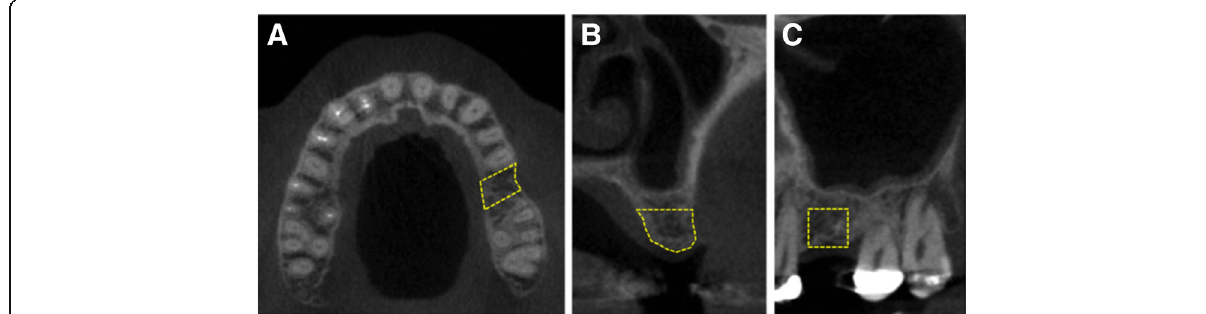
Fig. 2 Preoperative CT image showing the site for the definition of the ROI (simulated area delimited by a yellow dashed line for illustration purpose) in the axial ( a ), coronal ( b ), and sagittal (6 × 6 mm) ( c )